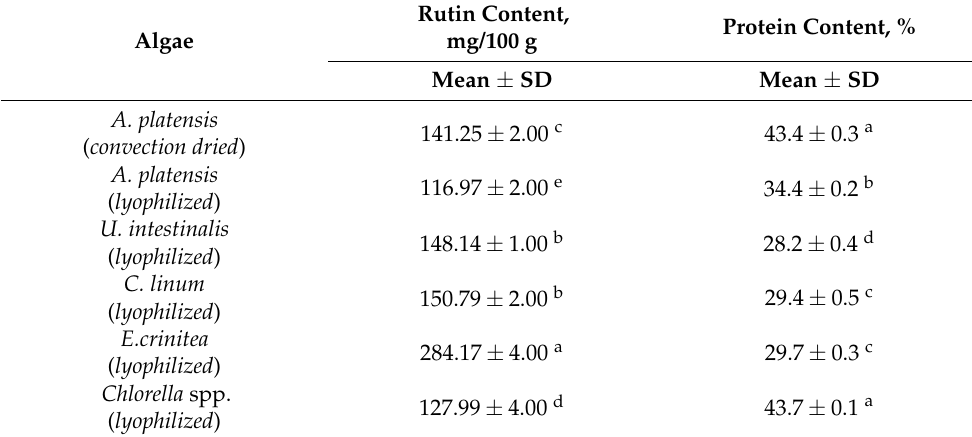
Table 7. Rutin content of algae, determined by HPLC method (mg/100 g), and protein contents (%). Rutin Content, Protein Content, % Algae mg/100 g Mean ± SD Mean ±